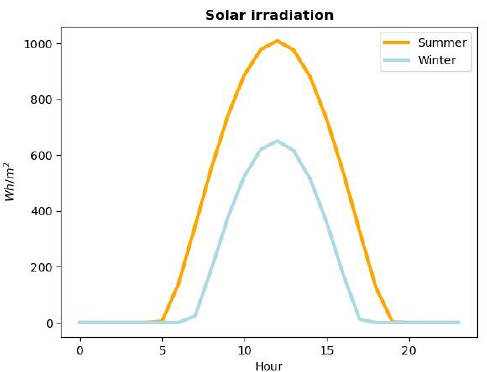
Figure 1. Daily solar radiation chart for a typical summer and winter day in the north of Mexico, Hermosillo, Sonora.